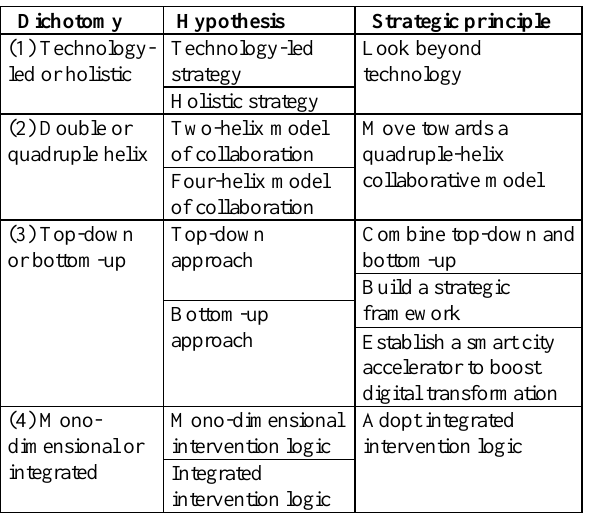
Table 2. Dichotomies, hypotheses, and strategic